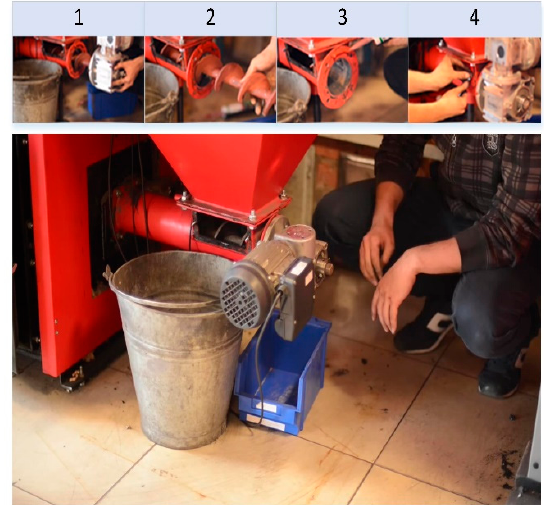
Figure 1. Four steps of sample activity (assembly of the auger and gear motor).